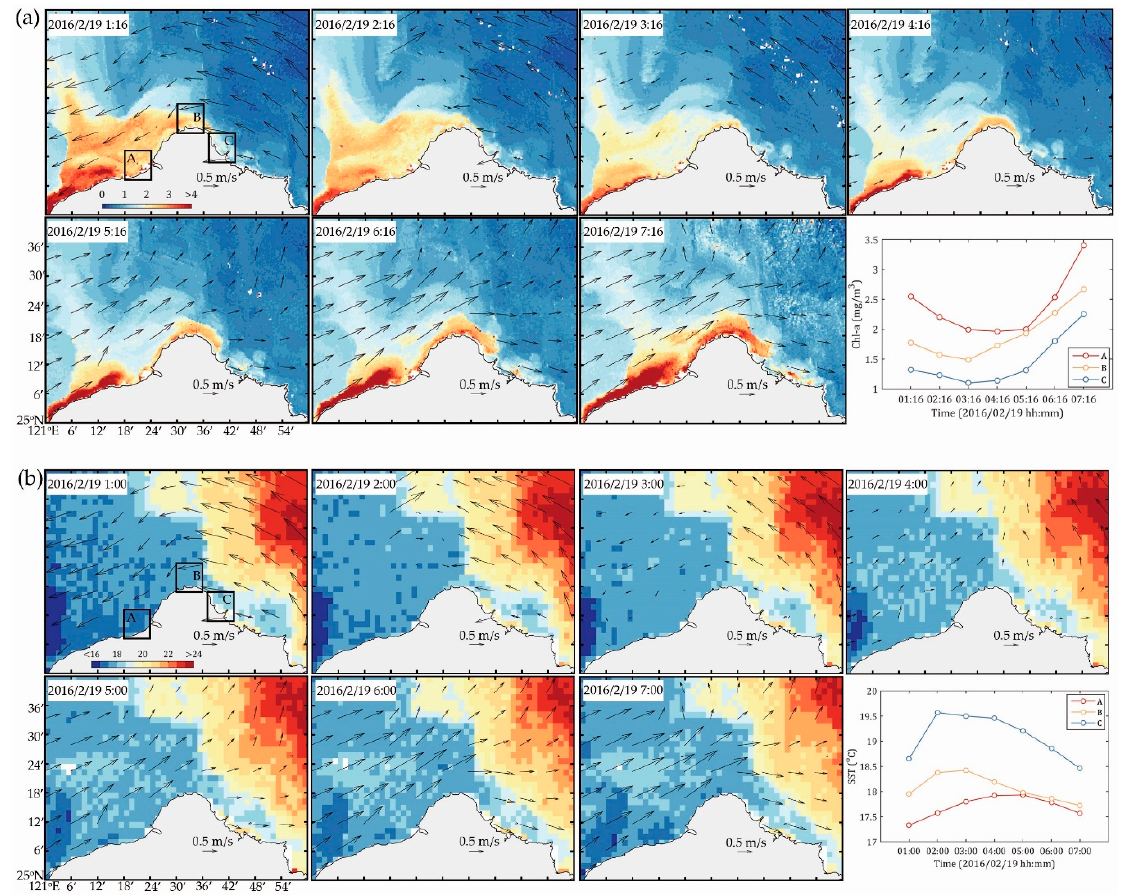
Figure 14. Short time period of ( a ) chlorophyll concentration and ( b ) SST variations with ocean currents from Feb 19, 2016, 1:00 to 7:00 (UTC). The areas A, B, and C in the time series diagram were selected as black boxes inside the map.